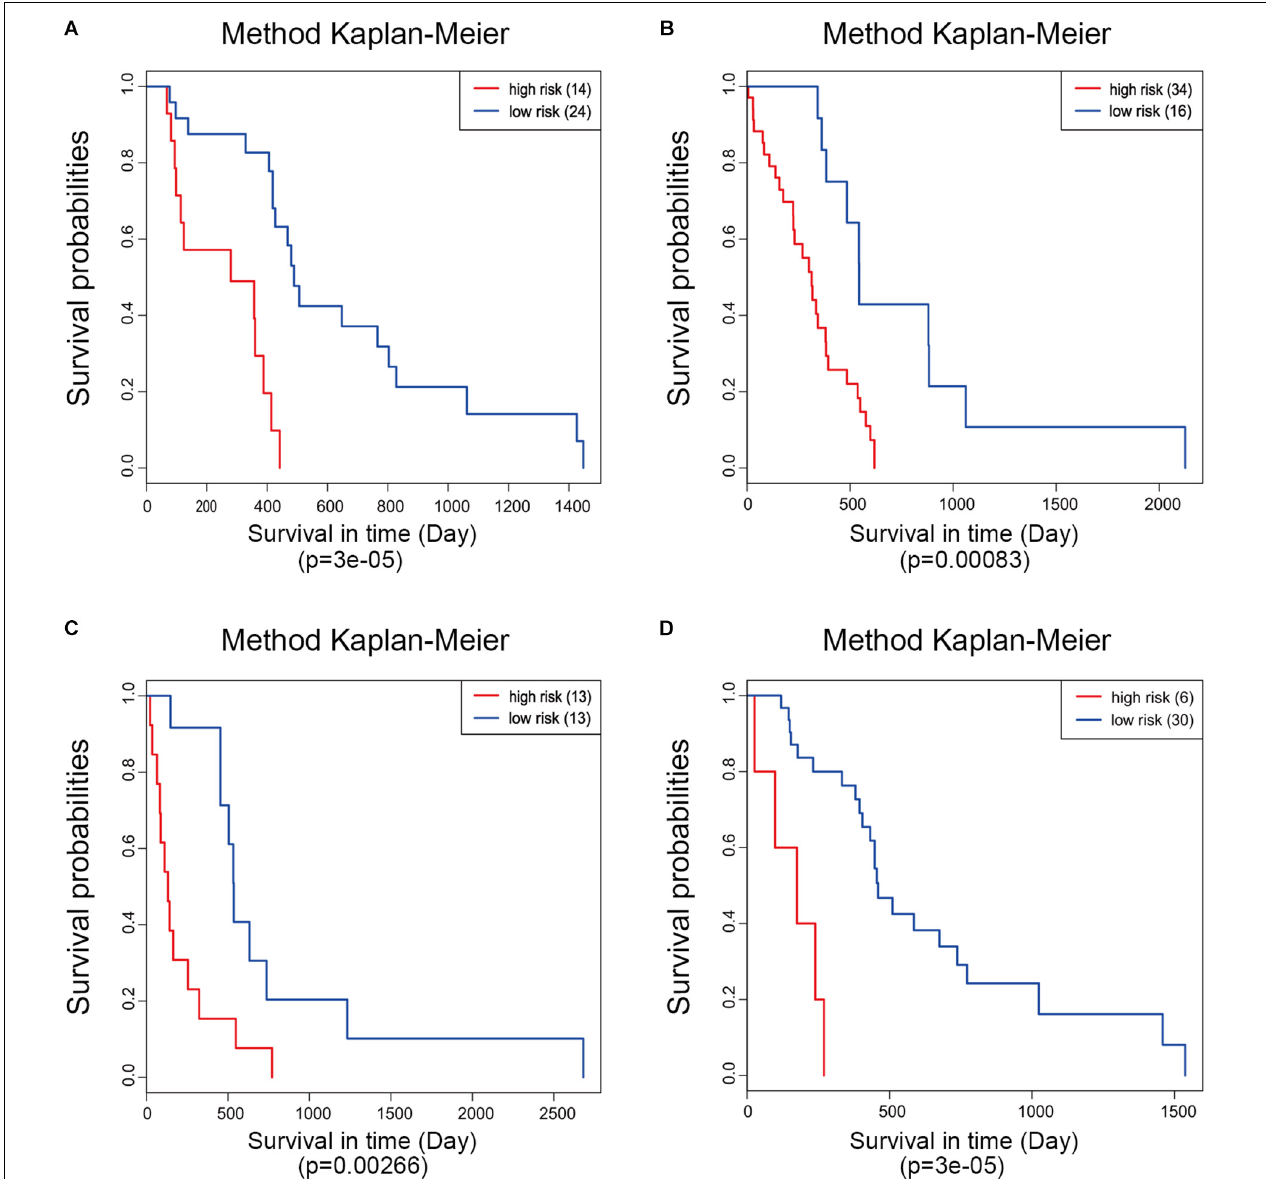
FIGURE 5 | Kaplan–Meier analysis of the five-gene signature in different molecular subtypes of glioblastoma. Classical (A) , mesenchymal (B) , neural (C) , and proneural (D) .